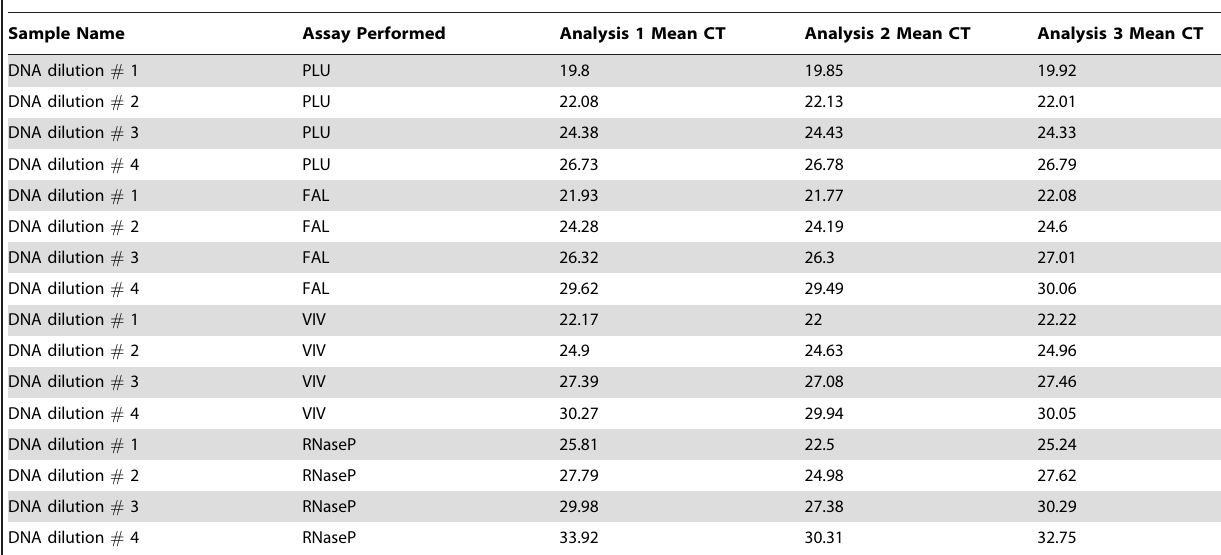
Table 2. Analysis of the multiplex real-time PCR